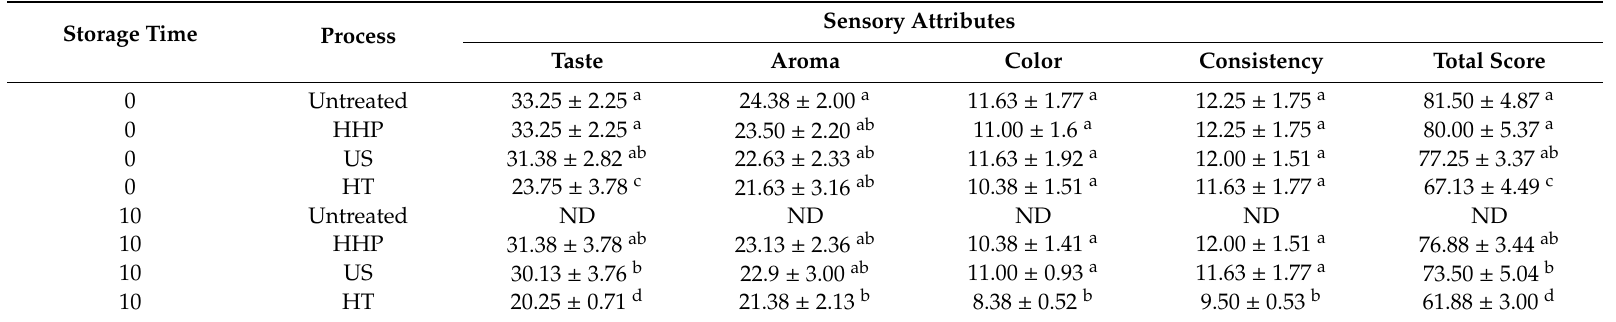
Table 4. Sensory scores of juice blends treated by HHP, US, and HT after 10 days of storage at 4 ◦